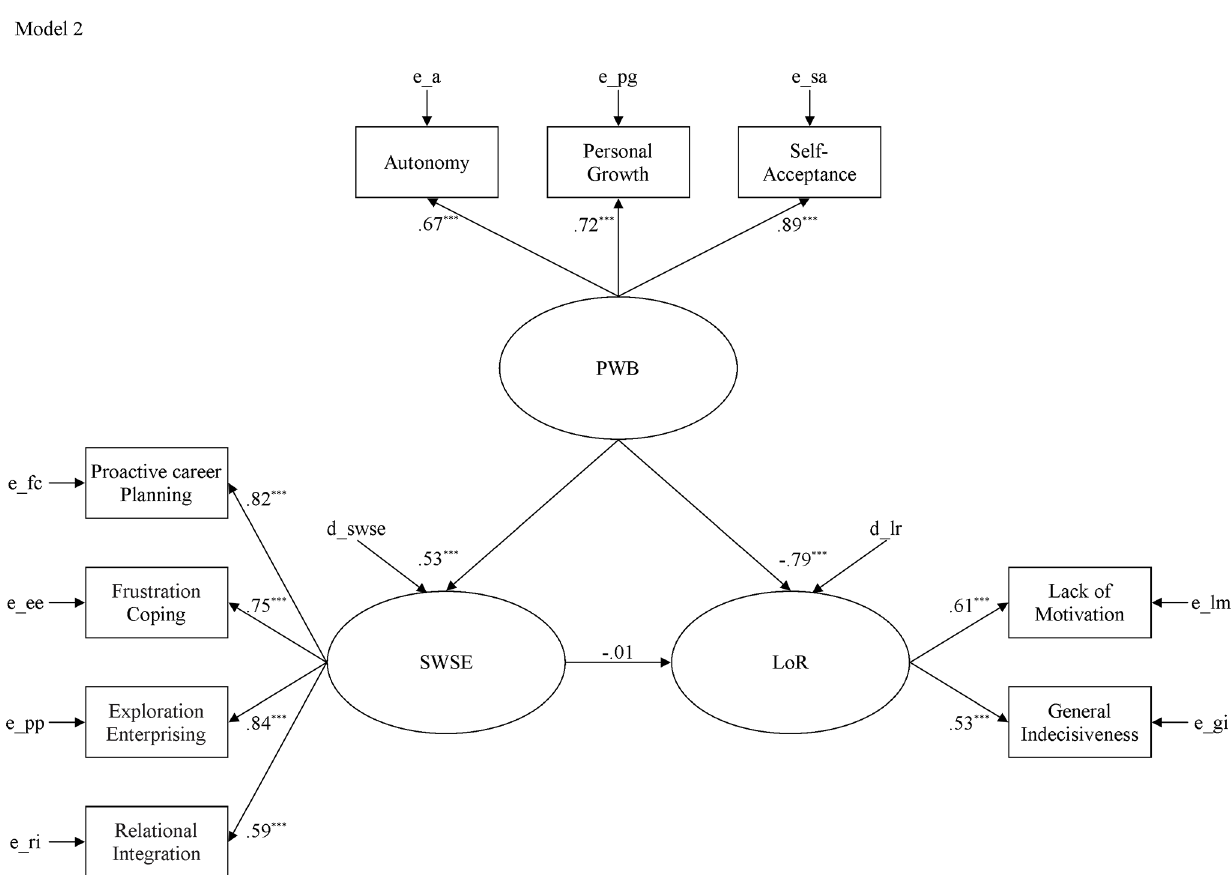
Figure 2. Estimated structural equation model for the relationships between search for work self-efficacy, lack of readiness, and psychological